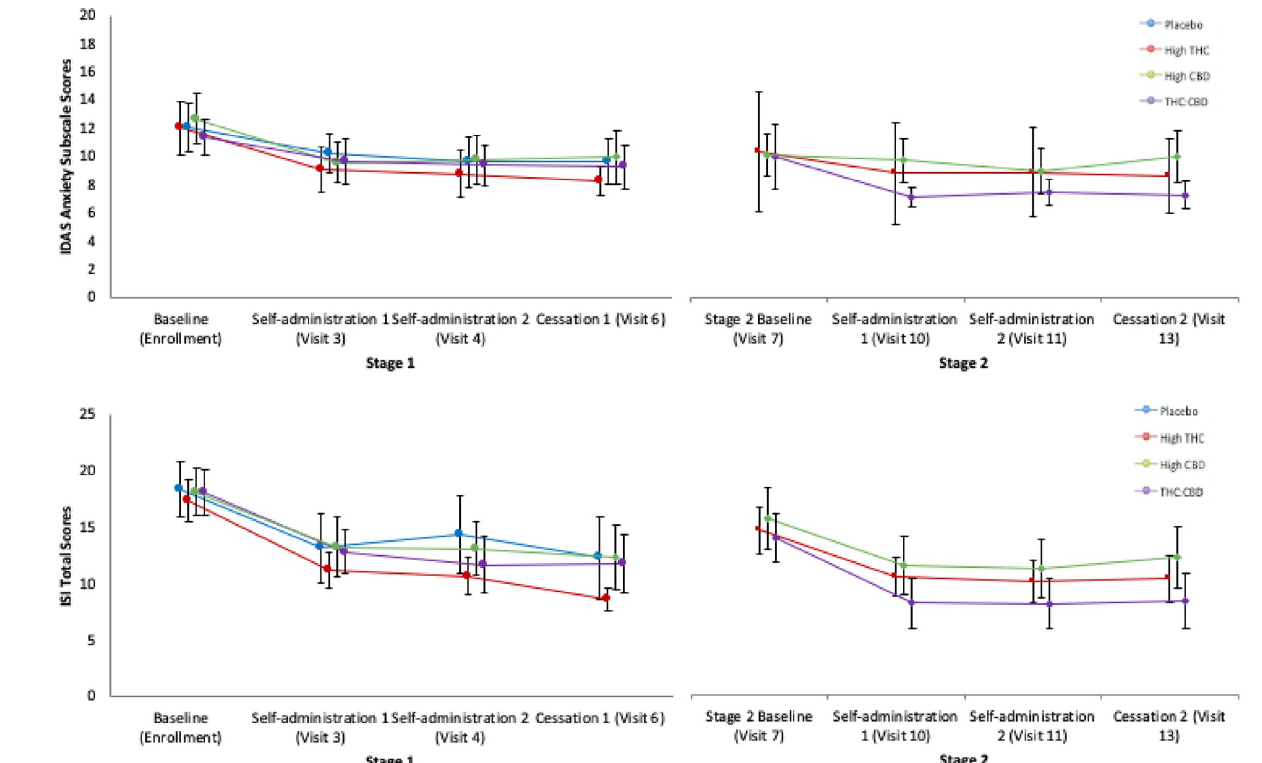
Fig 3. Post hoc Mixed Models for Repeated Measures (MMRM) testing change in PCL-5, IDAS depression, IDAS anxiety, and ISI scores over time.